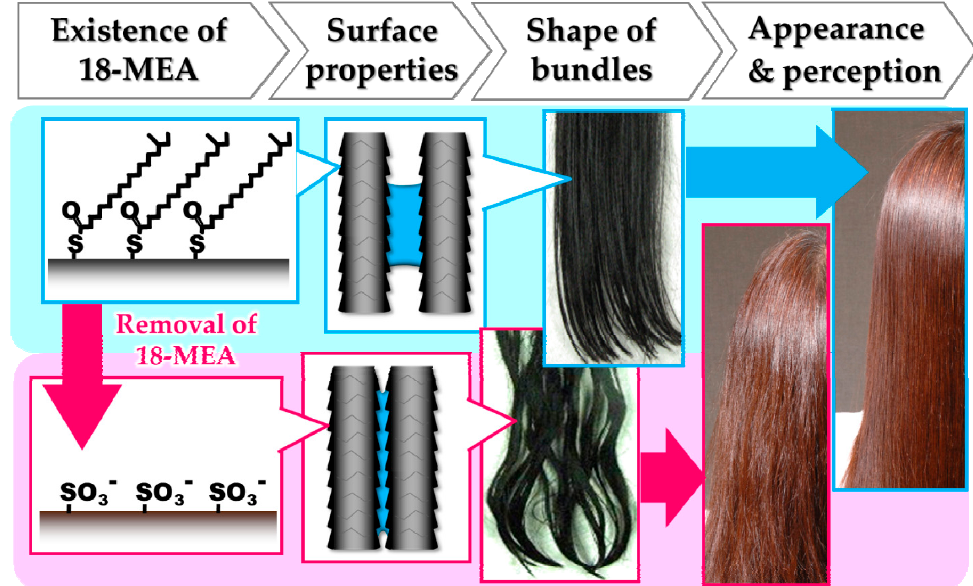
Figure 17. Schematic illustration how 18-MEA affects hair appearance and sensory pserception.